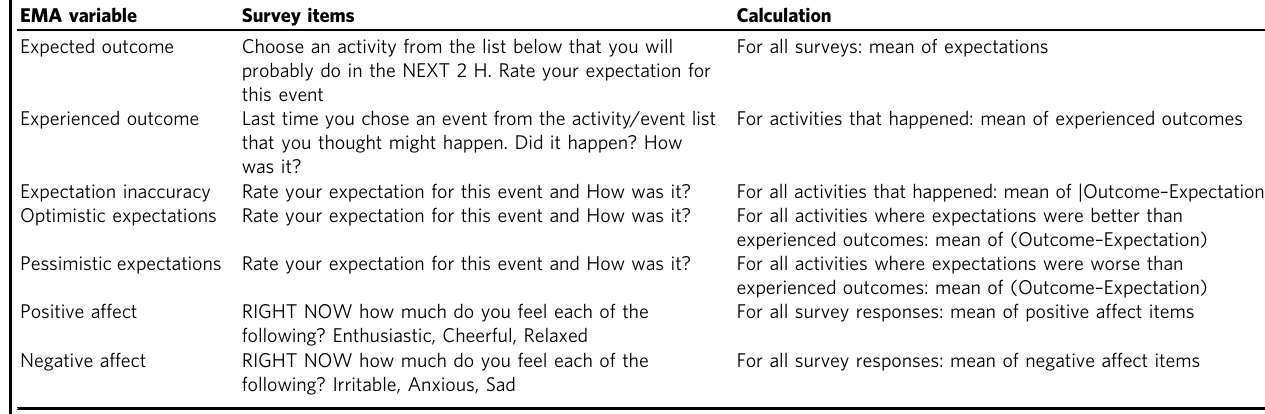
Table 2 Ecological momentary assessment (EMA) variable